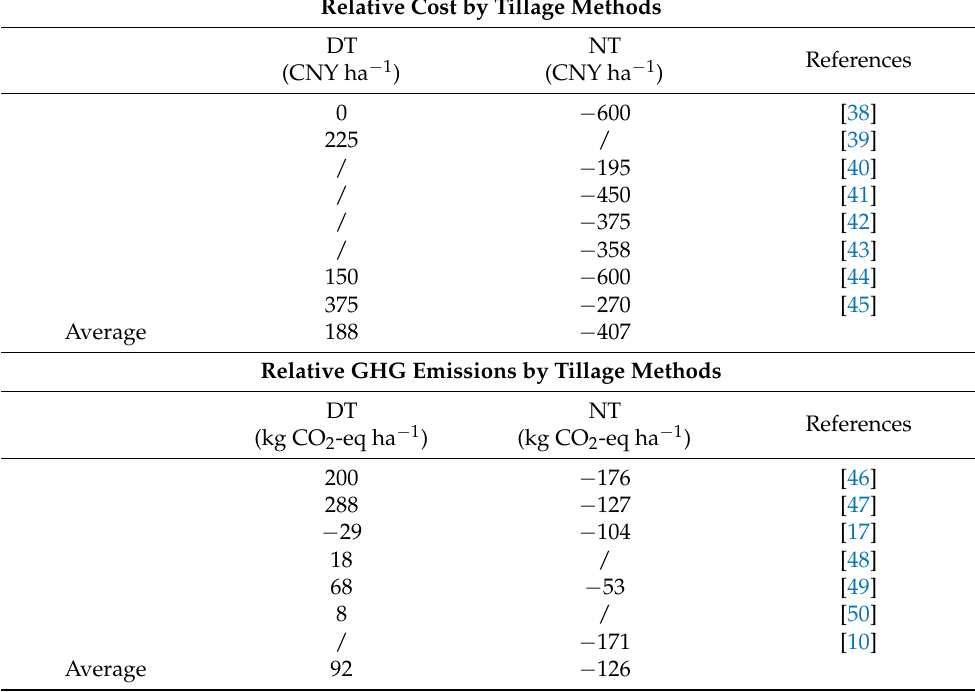
Table 1. Relative costs and GHG emissions of tillage methods. Relative tillage costs (CNY ha − 1 ) and GHG emissions (kg CO 2 -eq ha − 1 ) for DT and NT compared to RT. Values were obtained from the cited literature. GHG, greenhouse gas; CNY, Chinese yuan; DT, deep tillage; NT, no tillage; RT, rotary tillage. Relative Cost by Tillage Methods DT (CNY ha − 1